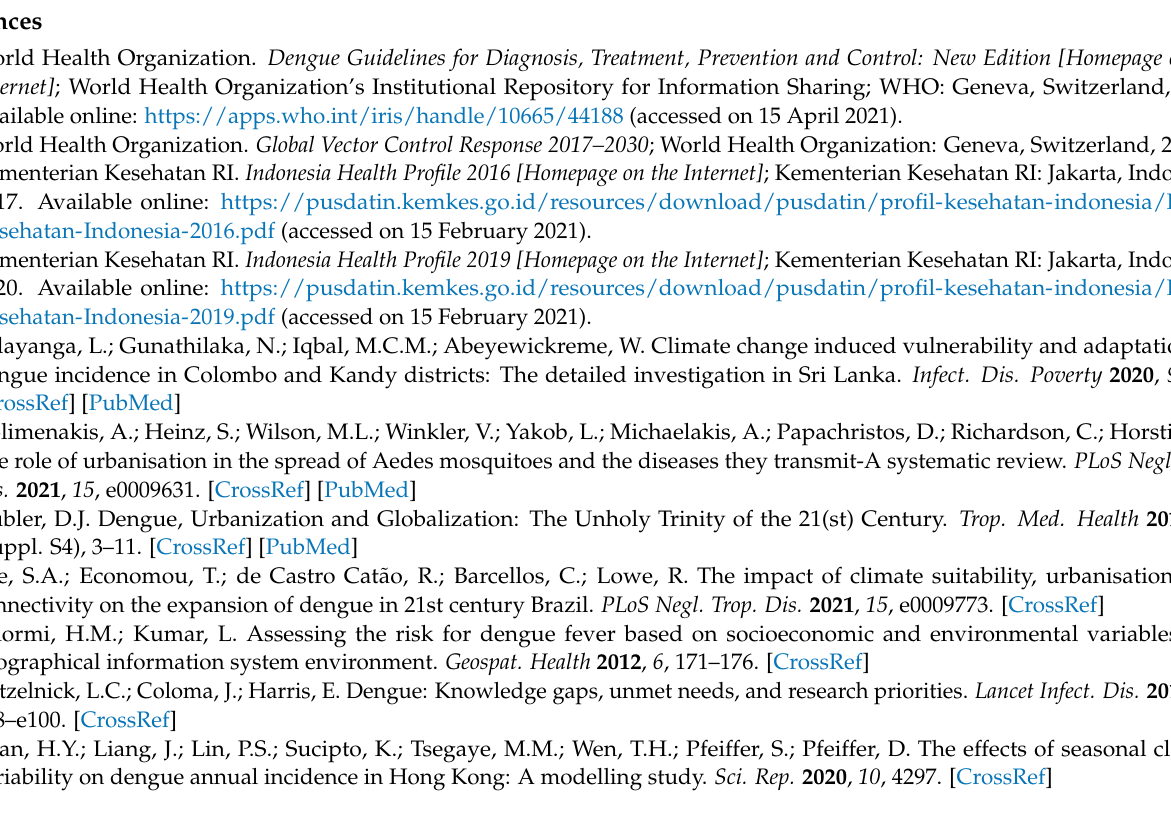
Figure A1. Difference between the risk assessment results and the data on the dengue number of cases in seven provinces of